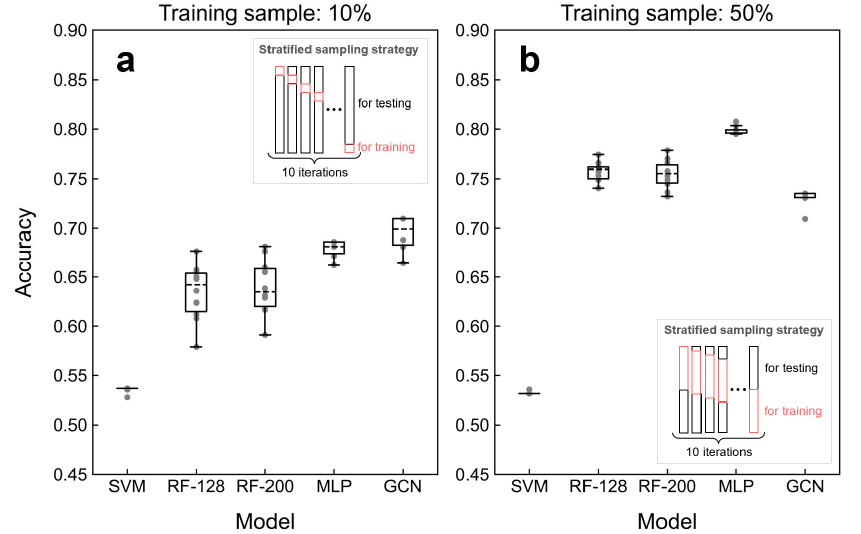
Figure 4. Cross validation results associated with five classification models ( a ) using small number of samples (10%) for training and ( b ) using large number of samples (50%) for training.